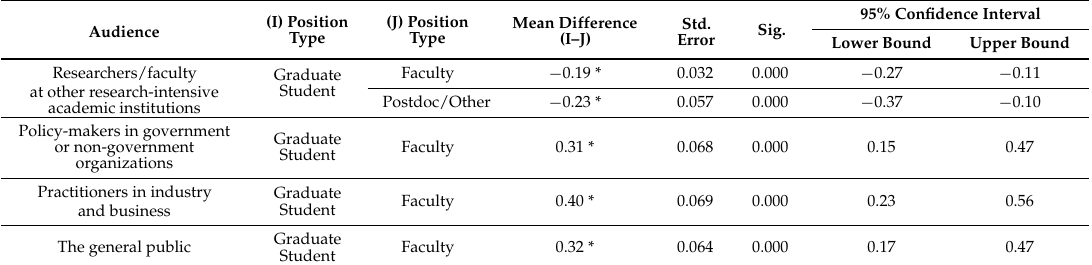
Table 12. Multiple comparisons, position type and audience (Tukey HSD).